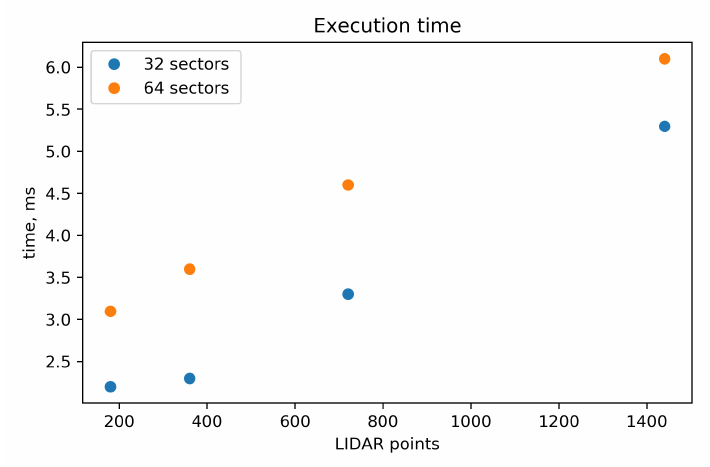
Figure 9. Algorithm execution